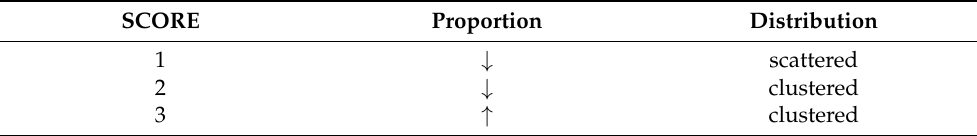
Table 3. Description of the immunoreactive score in liver samples depending on the proportion and the distribution of the RUNX1 positive cells. SCORE Proportion Distribution 1 ↓ scattered 2 ↓ clustered 3 ↑